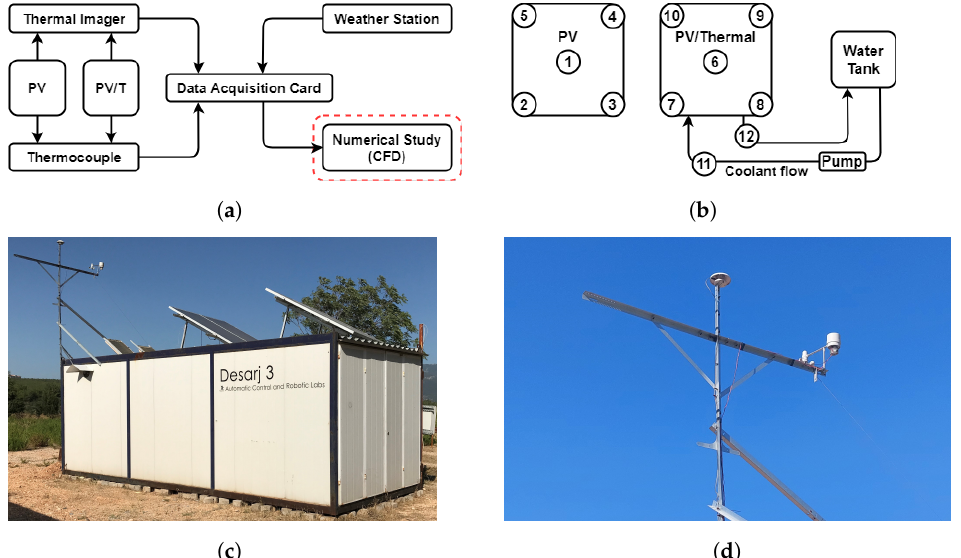
Figure 3. The working diagram of measurement instruments ( a ), temperature measurement points with thermocouples on the PV/T and PV modules ( b ), isometric view of the experimental environ- ment ( c ), and the weather station ( d